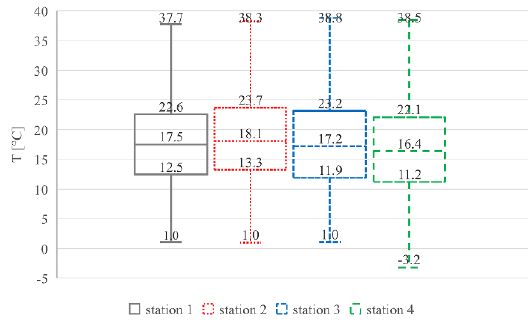
Figure 4. Statistical analysis of hourly temperatures at the four stations: maximum value, minimum value, first quartile, average, third quartile.